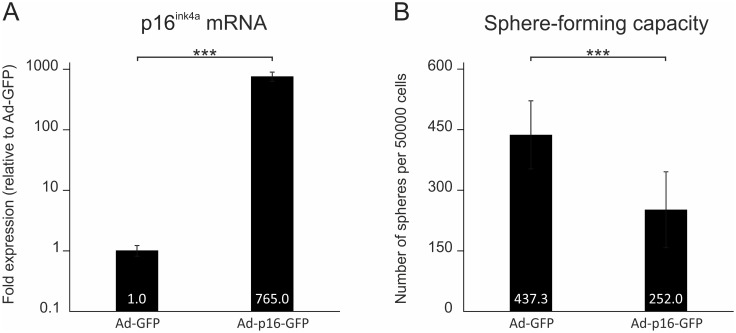
Effect of viral vector-mediated p16ink4a overexpression on the sphere-forming capacity of the organ of Corti.(A) Quantitative analysis of p16ink4a mRNA levels in otospheres, derived from wildtype organ of Corti specimens after 5 days in vitro. The organ of Corti-derived cells were incubated with either of two viral vectors: i) Ad-GFP to induce the expression of GFP, or Ad-p16-GFP to induce the expression of both GFP and p16ink4a. The spheres incubated with Ad-p16-GFP showed a 765-fold increase in p16ink4a mRNA levels compared to the spheres incubated with Ad-GFP (n = 2 independent samples, measured in triplicate, for both groups). The difference in p16ink4a mRNA levels between the Ad-GFP and Ad-p16-GFP groups was highly statistically significant (Student’s t-test, p<0.001). (B) Average number of spheres generated after 5 days in vitro per 50000 cells plated (mean ± standard deviation). Cells incubated with Ad-p16-GFP generated significantly fewer spheres, after 5 days in vitro, compared to the cells incubated with Ad-GFP (N = 3 independent experiments, n = 5 replicates per experiment, Student’s t-test, p<0.001). ***p<0.001.